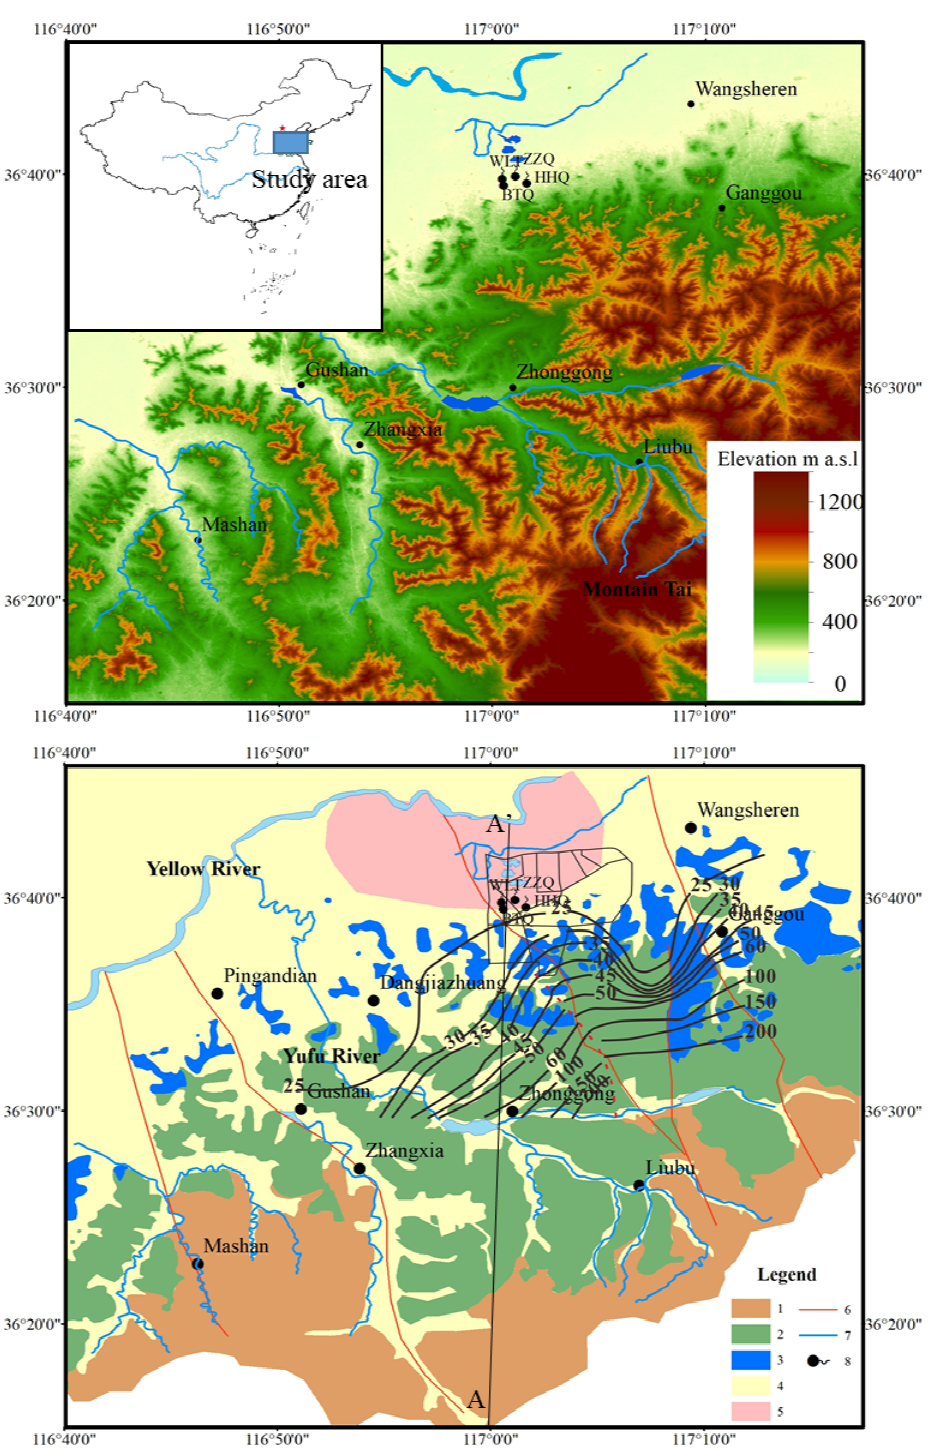
Figure 1. Topographic and generalized geological map in the Jinan karst spring system. (1. Archaean metamorphic rocks; 2. Cambrian limestone; 3. Ordovician limestone; 4. Quaternary sediments; 5. Magmatic rocks; 6. Fault; 7. River; and 8. Spring. The numbers in figure represent the groundwater level obtained from Sun [58] and they show a high hydraulic gradient in direction of southwest for Baotu Spring and southeast for Heihu Spring.)